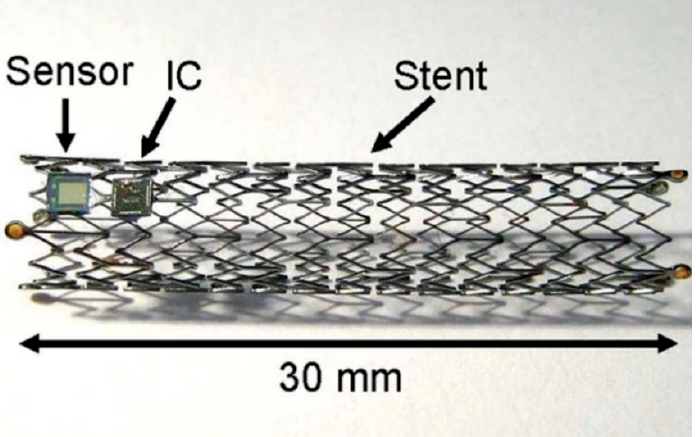
Figure 5. An example of a remote-powered blood pressure sensor. Power is received via the stent, which doubles as an antenna, to power the sensor and processing integrated circuit (IC). Reprinted with permission from Reference [110] .